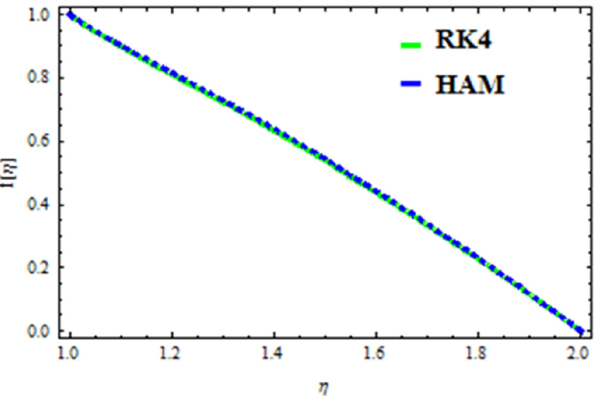
Figure 23. Comparison of RK4 and HAM for velocity under constant viscosity.